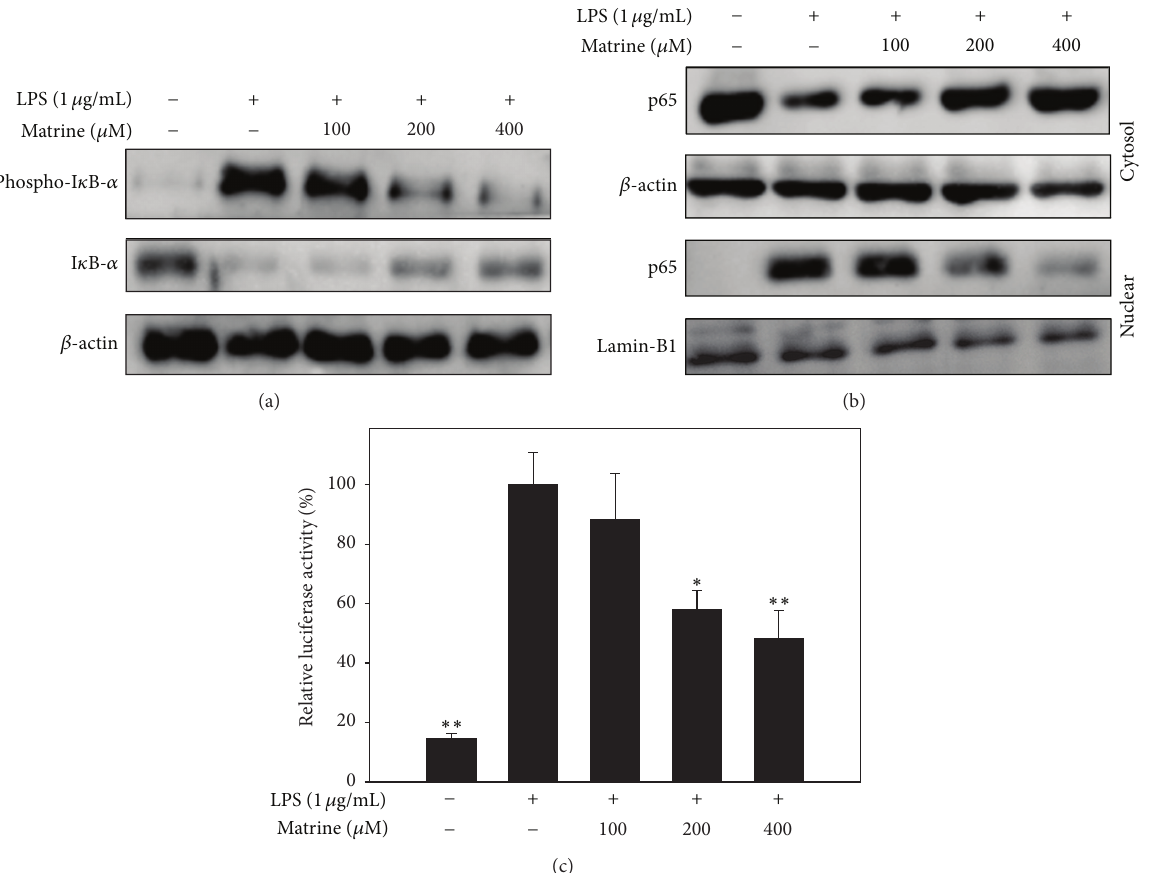
Figure 3: Matrine inhibits the nuclear translocation of NF- 𝜅 B in A549 cells. (a) Effects of matrine on the LPS-induced phosphorylation of I 𝜅 B- 𝛼 , with total I 𝜅 B- 𝛼 levels used as internal controls. (b) To assess the nuclear translocation of NF- 𝜅 B, cells were pretreated with different matrine concentrations for 1h and then incubated with LPS (1 𝜇 g/mL) for 1h. The internal controls were lamin B1 in the nucleus and 𝛽 -actin in the cytosol. (c) Matrine suppressed luciferase activity by the NF- 𝜅 B promoter assay. Three independent experiments were analyzed and compared with the LPS-treated control group. Data are presented as the mean ± SEM. ∗ 𝑃 < 0.05 compared to LPS alone.